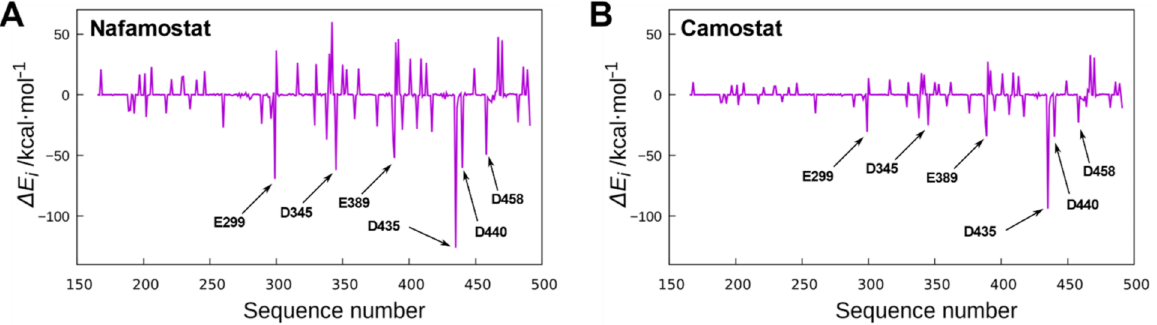
Figure 3. Contribution of amino acids to the binding energy of ( A ) nafamostat and ( B ) camostat. The positive and negative peaks represent repulsive and attractive interactions, respectively. The respective interaction energies were calculated using Equation (1). The arrows indicate the amino acids that contribute significantly to the binding energy. In both ( A , B ), the strongest attractive interaction arises from Asp435, while a strong attractive interaction with Glu299 is observed in ( A ), but not in ( B